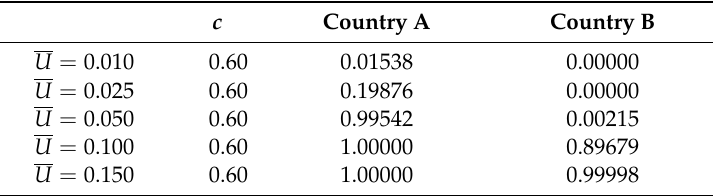
Table 1. Effects of U on the probability of reaching the debt ceiling c